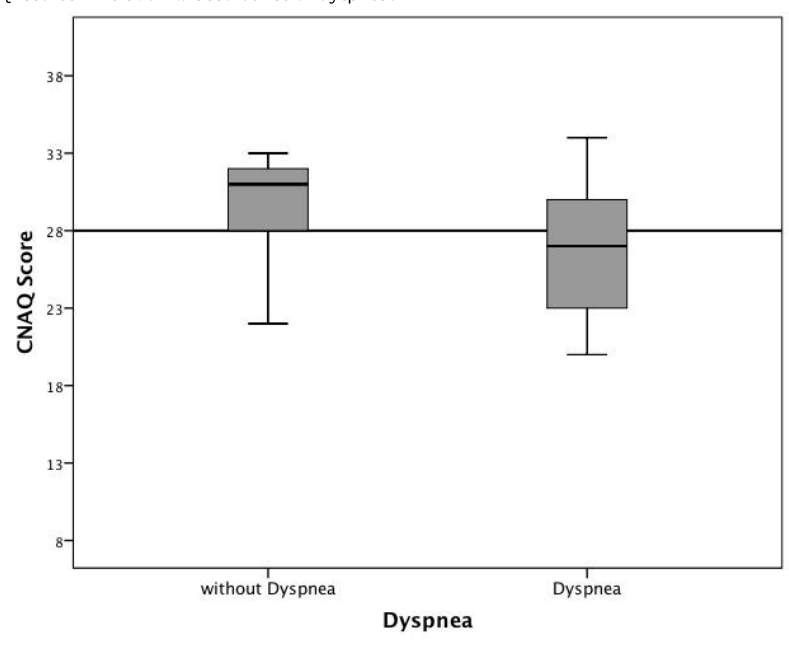
Figure 2. Box plots of CNAQ scores in relation to accordance of dyspnea.